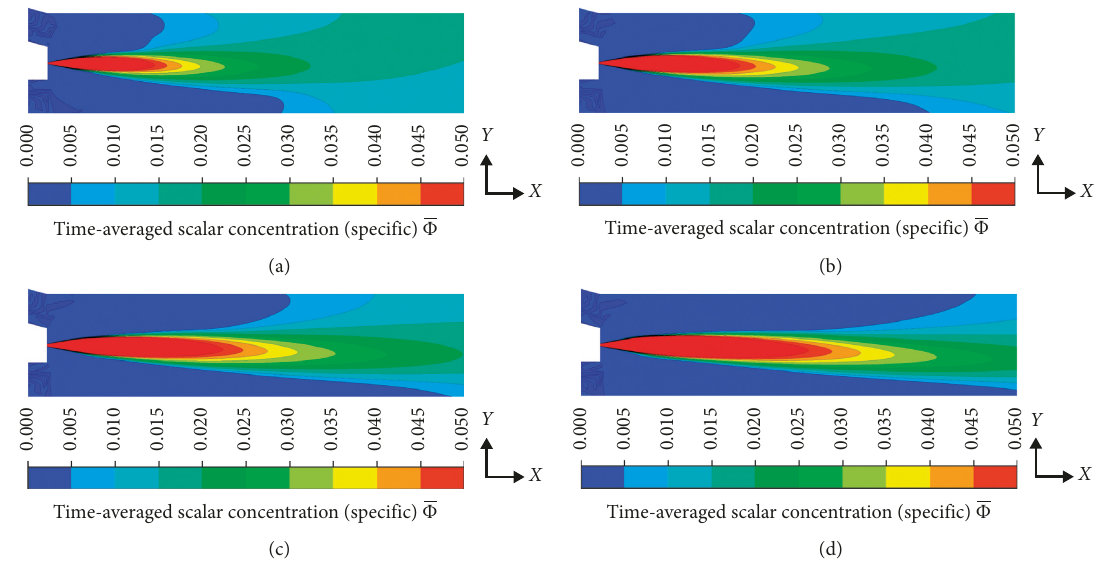
Figure 5: The time-averaged passive scalar fields changing with Re on the symmetry plane XOY: (a) Re � 37240; (b) Re � 27972; (c) Re � 24827; (d) Re �